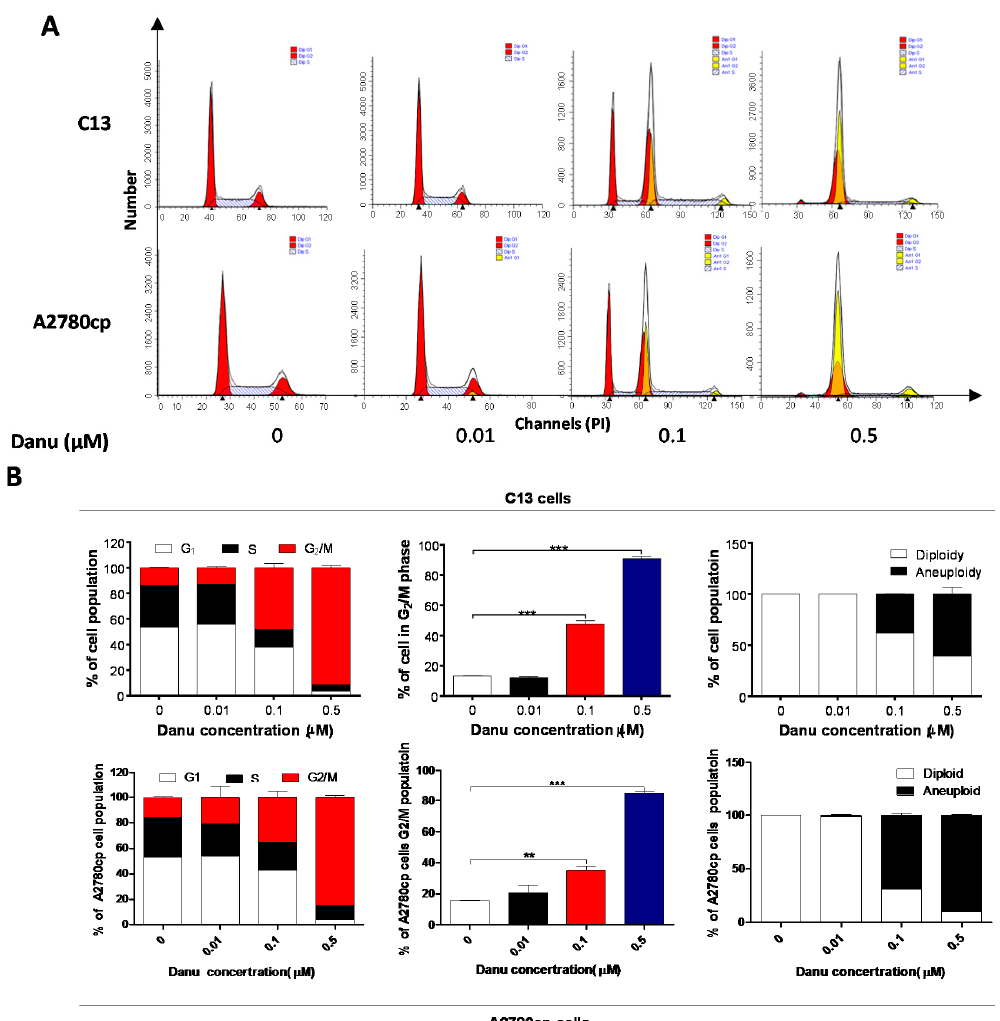
Figure 2. Danu induces cell cycle arrest in G 2 /M phase in C13 and A2780cp cells. Cells were treated with Danu at 0.01, 0.1, and 0.5 μ M for 24 h and then subject to flow cytometry. ( A ) Flow cytometric plots of cell cycle distribution of C13 and A2780cp cells and ( B ) bar graphs showing the percentage of C13 and A2780cp cells in G 1, S, and G 2 /M phases and the percentage of diploidy and polyploidy in C13 and A2780cp cells. Data represent the mean ± SD of three independent experiments. ** p < 0.01 and *** p < 0.001 by one-way analysis of variance.